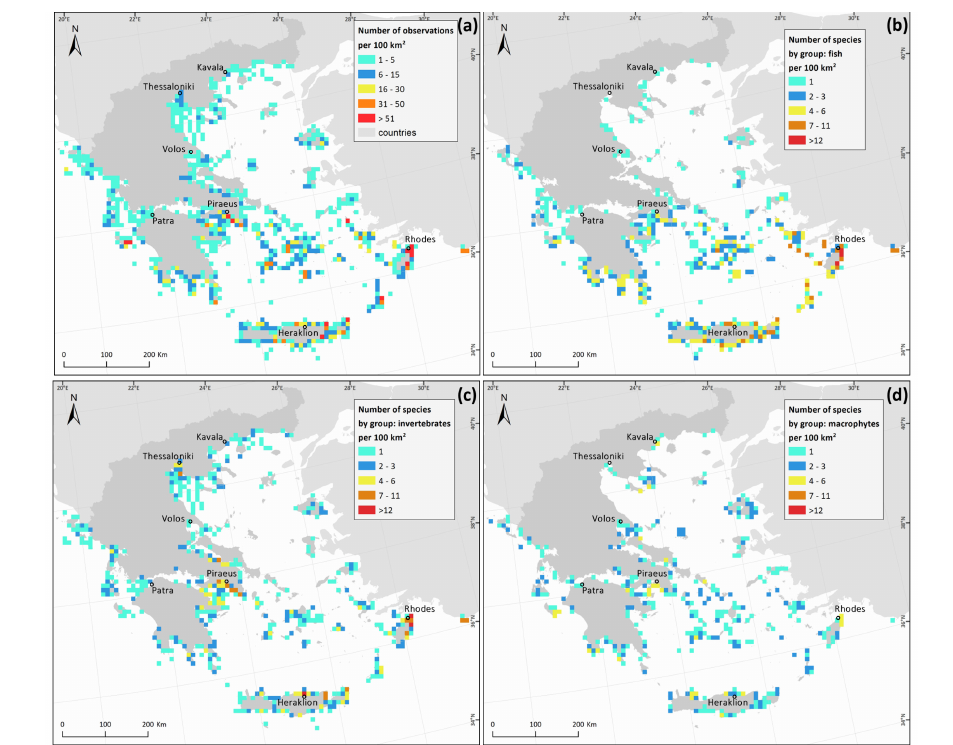
Figure 3. Maps of the Greek Seas depicting the total number of records ( a ) as well as the total number of ICAS belonging to different taxonomic groups, i.e., fishes ( b ), invertebrates ( c ), and marine macrophytes ( d ). Grid cells were produced using the 10 × 10 km European Environmental Agency (EEA) reference grid. The resulting dataset consisted of 5478 records: 61.5% from the Aegean Sea, 19.6% from the Levantine Sea, 18.6% from the Ionian Sea, and 0.3% from the Adriatic. The majority of the records were retrieved from the published scientific literature (47.4%), followed by offline databases (25.6%), in situ underwater sampling during the ALAS project (11.4%), independent observations (7.3%), social media (4.9%), online databases (1.9%), communications with divers (0.7%), and grey literature (0.7%). At the phylum level, Chordata (mainly fishes) accounted for 52.2% of the total number of records, followed by Mollusca (10.2%), Arthropoda (9.6%), Rhodophyta (8.2%), and Chlorophyta (7.4%), with the remaining phyla representing less than 5.0% of the records each (Table 1). At the species level, 15 taxa with more than 100 records each accounted for 78% of the records and presented the most widespread distribution throughout the Greek Seas (Table 1). Based on their numbers of records, in decreasing order, these taxa were: Siganus luridus, S. rivulatus, Pterois miles, Caulerpa cylindracea, Percnon gibbesi, Lagocephalus sceleratus, Lophocladia lallemandii, Fistularia commersonii, Pinctada radiata, Torquigener flavimaculosus, Halophila stipulacea, Conomurex persicus, Diadema setosum, Callinectes sapidus, and Asparagopsis spp. (including A. armata : 25 records, A. taxiformis : 72 records, and unidentified Asparagopsis sp.: 7 records).